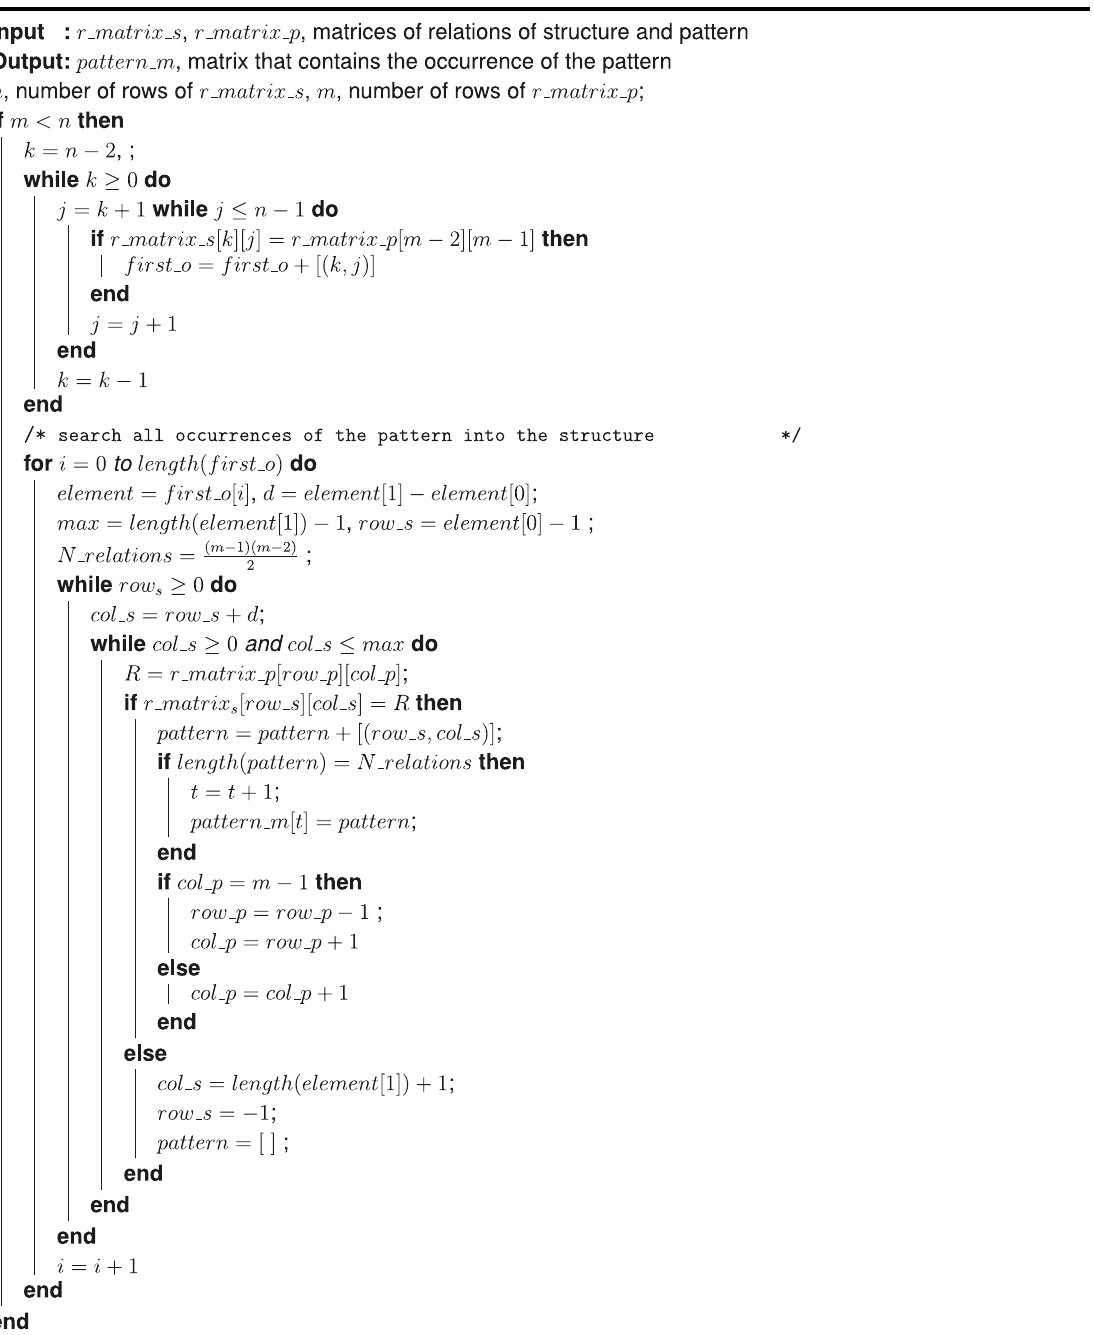
Algorithm 4: Structural relation